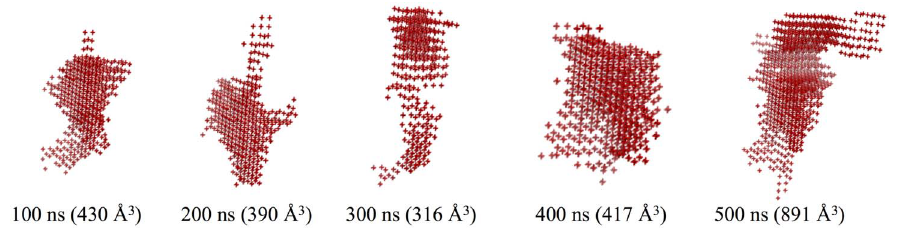
Fig. 8. Representation of the pocket binding site as detected with the POCASA software. The shape comes from the gathering of the positions of the POCASA probe sphere explored every 100 th ns frame of the 0.5 m s all-atom MD simulation of the m OR structure. The five pockets illustrate the variation of the binding site shape during the